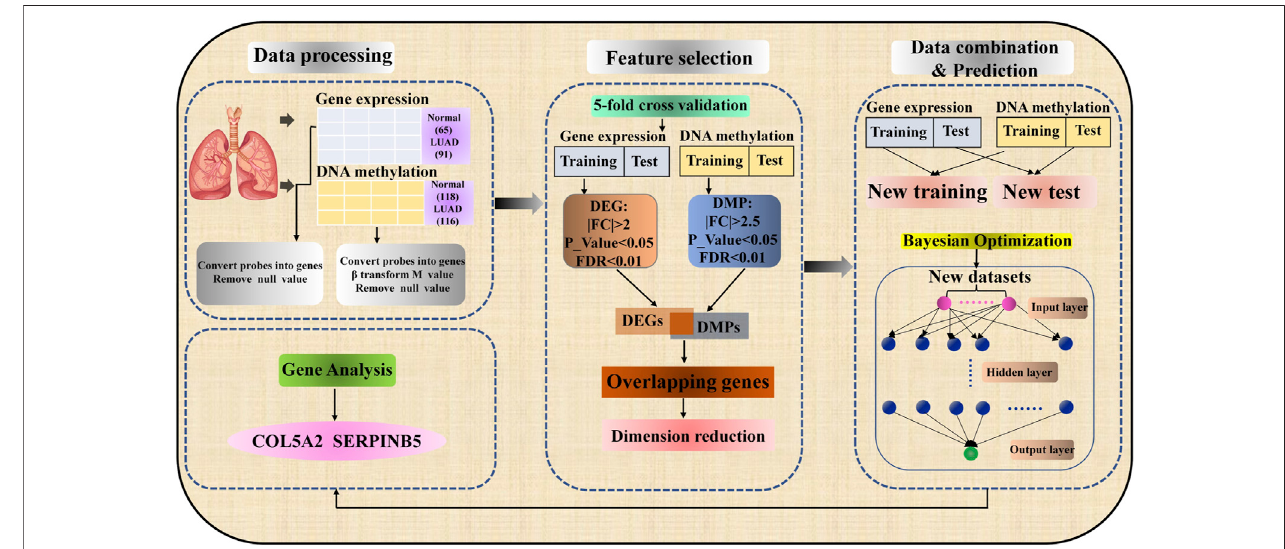
FIGURE 1 | Work fl ow of lung adenocarcinoma prediction and biomarker recognition.